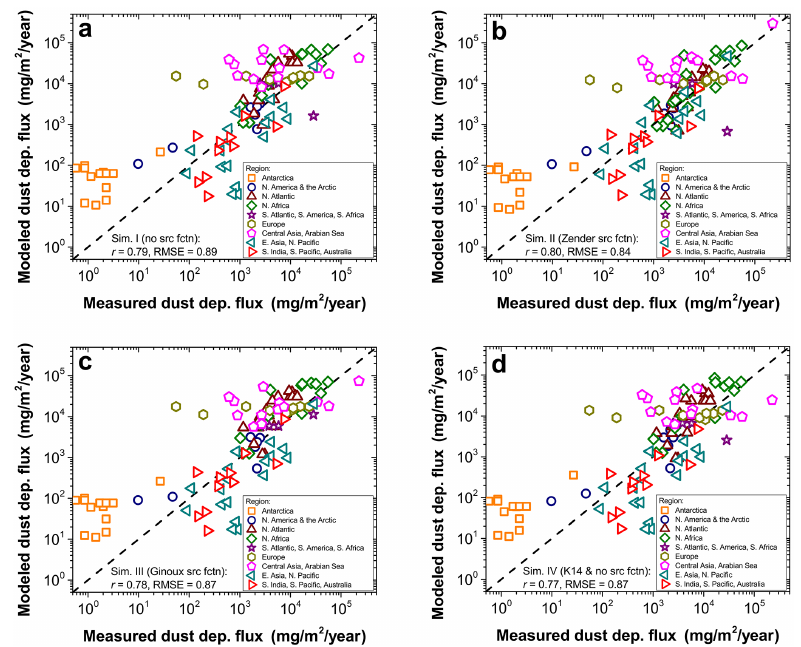
Figure 8. Comparison of the modeled dust deposition flux with that measured at 110 stations (see Sect. 2.3.2). Results are shown for (a) simulation I (no source function), (b) simulation II (Zender et al. (2003b) source function), (c) simulation III (Ginoux et al. (2001) source function), and (d) simulation IV (no source function, and dust flux is parameterized following K14 instead of Z03). For each panel, the RMSE and r in log10-space are